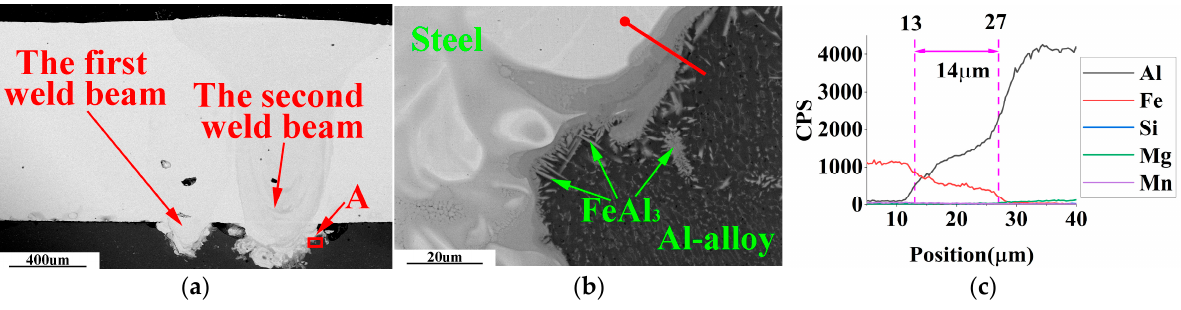
Figure 9. SEM-EDS observation of weldment with weld spacing of 0.5 mm. ( a ) Main areas of weld cross-section; ( b ) enlarged view of area A in Figure 9a; ( c ) EDS line scan results of the red line in Figure 9b.